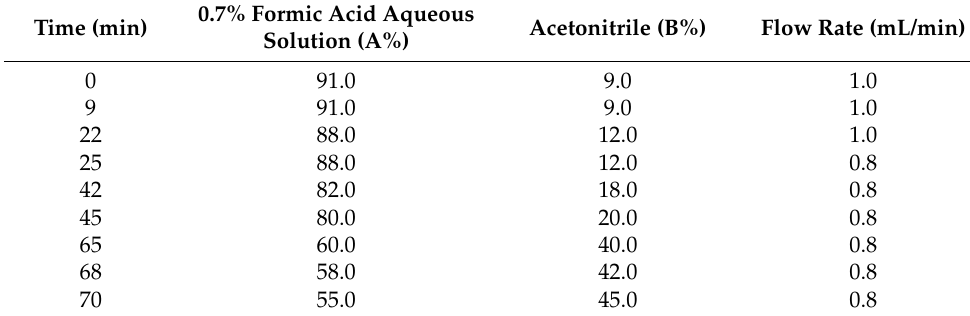
Table 7. Gradient elution